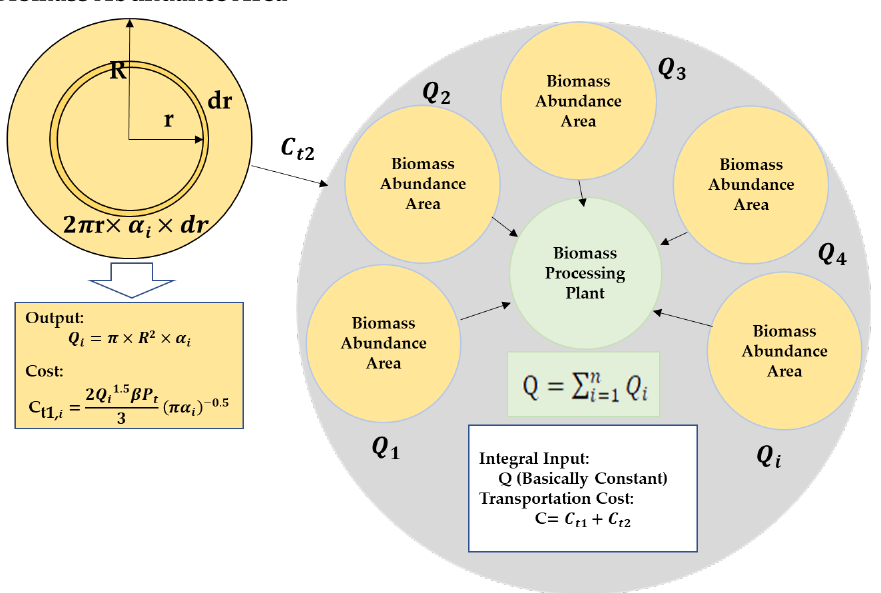
Figure 7. Biomass resource island distribution model and collection process illustration.